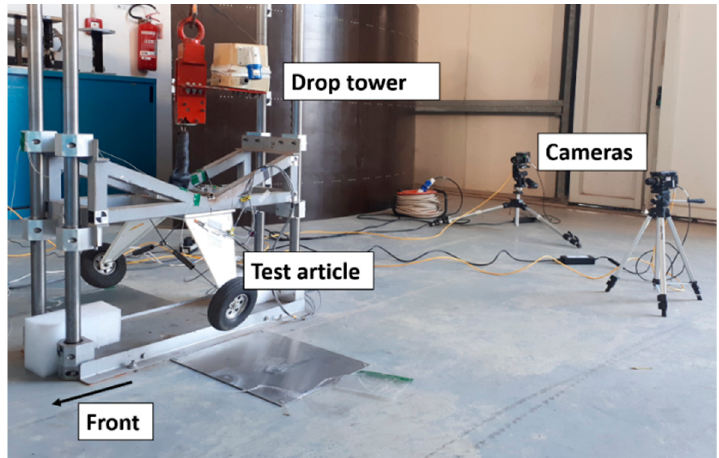
Figure 11. Camera layout.